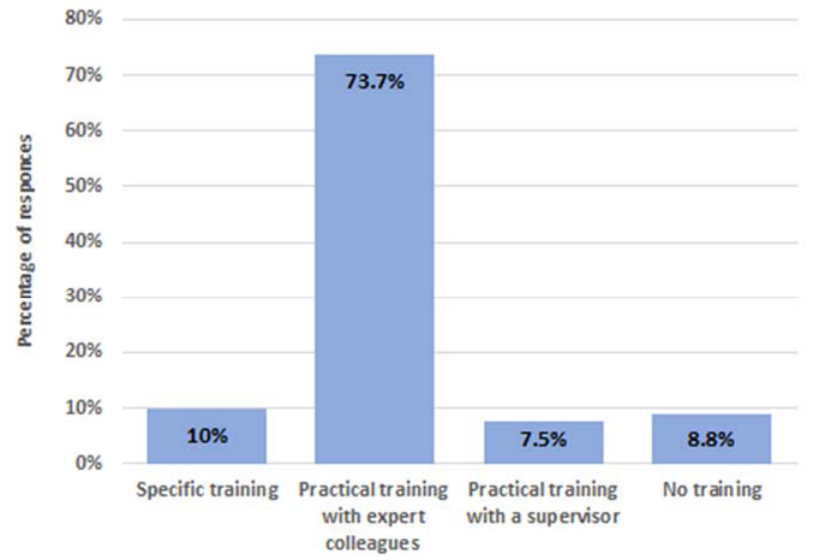
Figure 3. Percentage distribution of the training methods carried out in the respondent endoscopic centers (80 responders).